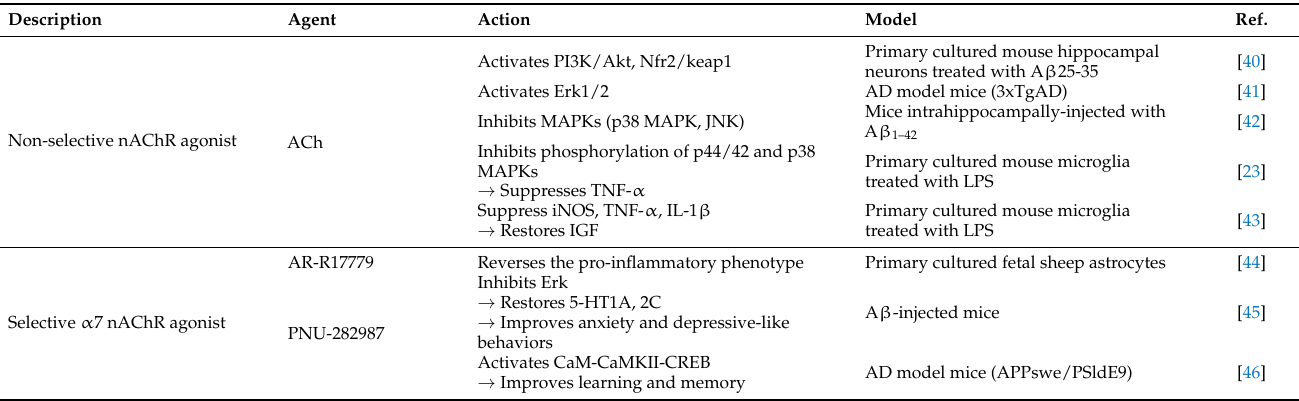
Table 1. Neuroprotective effects of nAChR-related